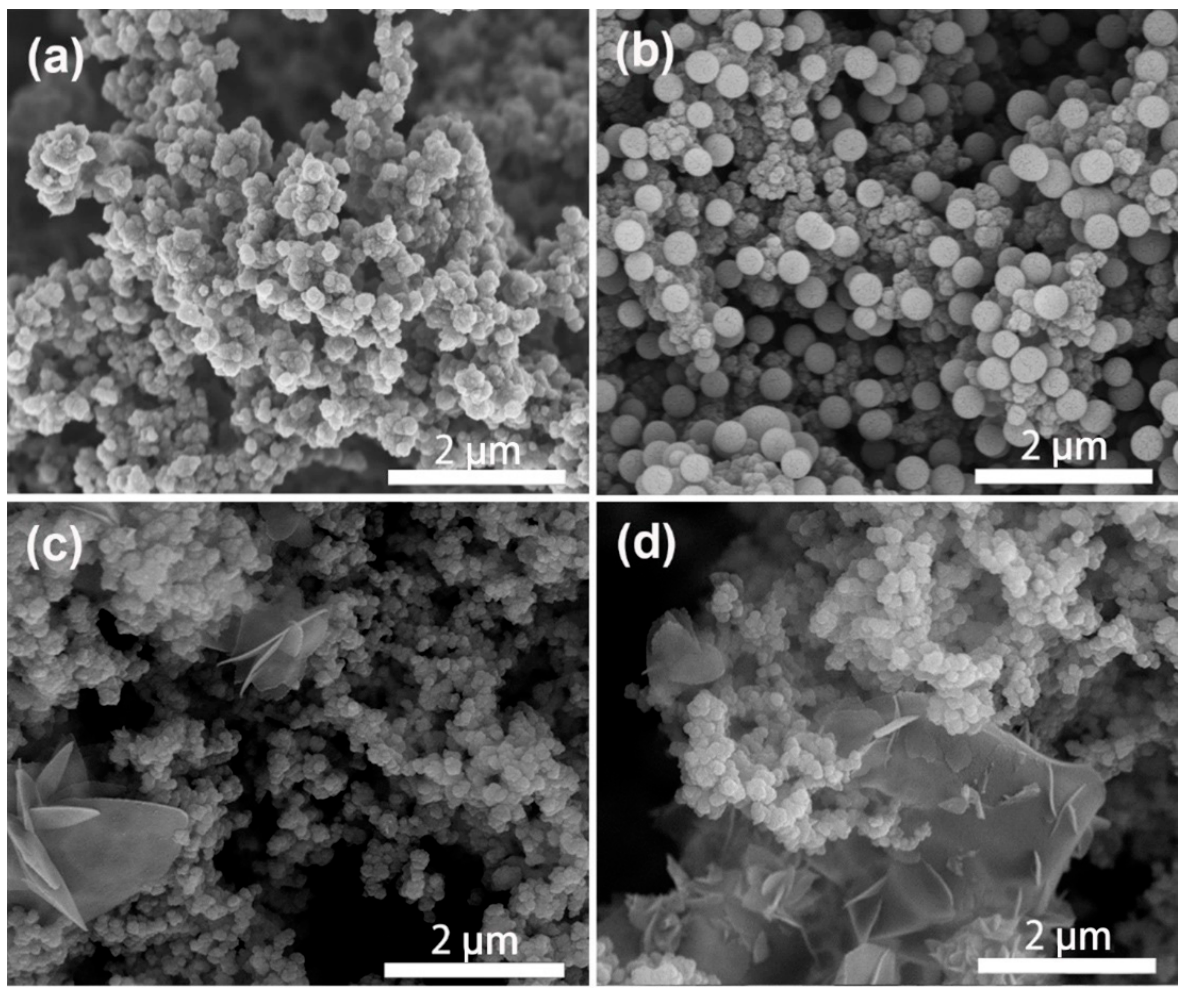
Figure 5. SEM of PPy/HSB composites of PPy/HSB-0.3 ( a ), PPy/HSB-0.6 ( b ), PPy/HSB-1.2 ( c ) and PPy/HSB-1.8 ( d ).